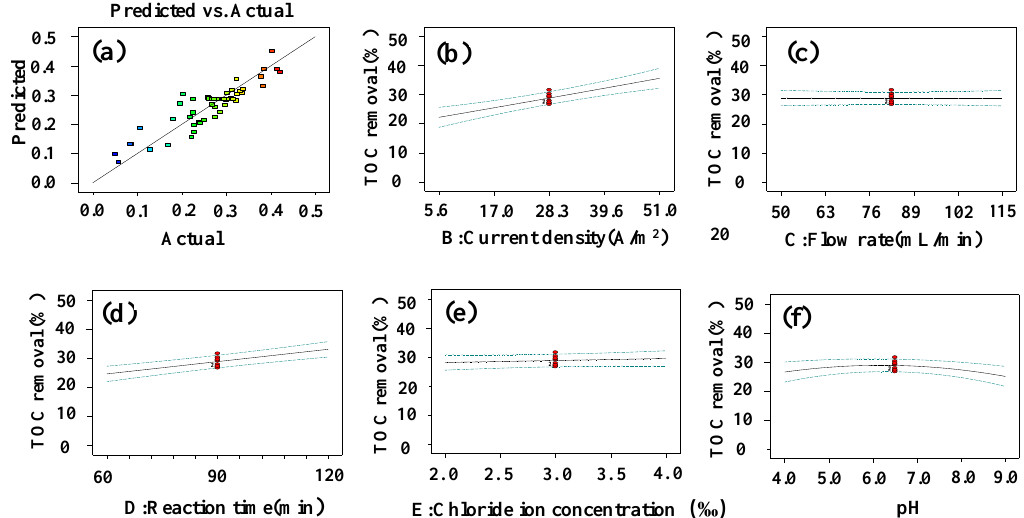
Figure 4. ( a ) Staggered normal distribution diagram. ( b – f ) Influence of single factor on TOC removal.